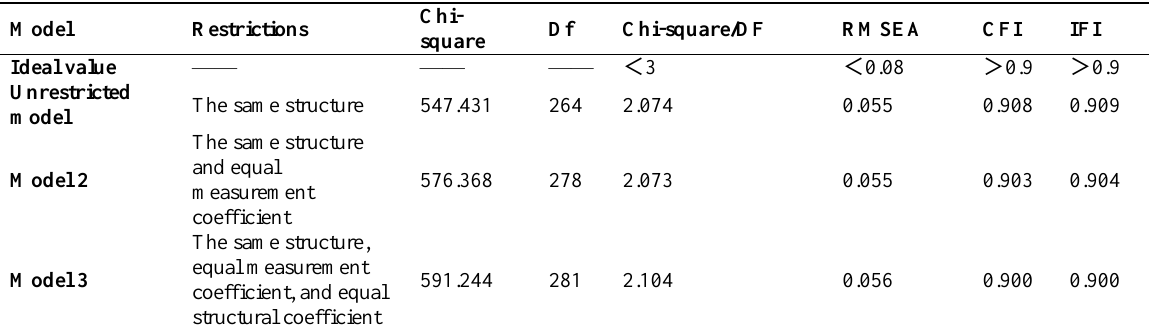
Table 11: Model fit index